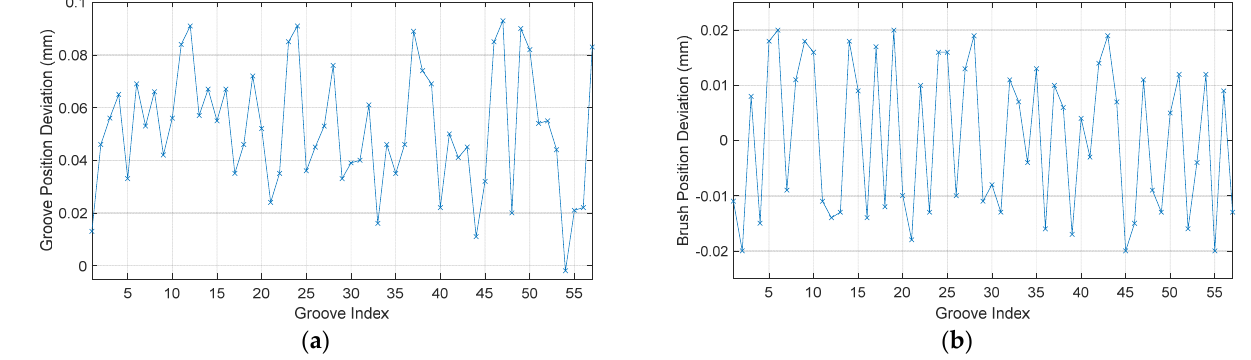
Figure 13. System measurement results: ( a ) Slip groove position error; ( b ) Brush assembly error.